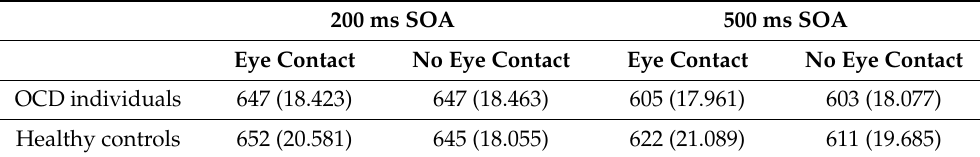
Table 1. Mean latencies (in ms) and SEM observed in both groups in all experimental